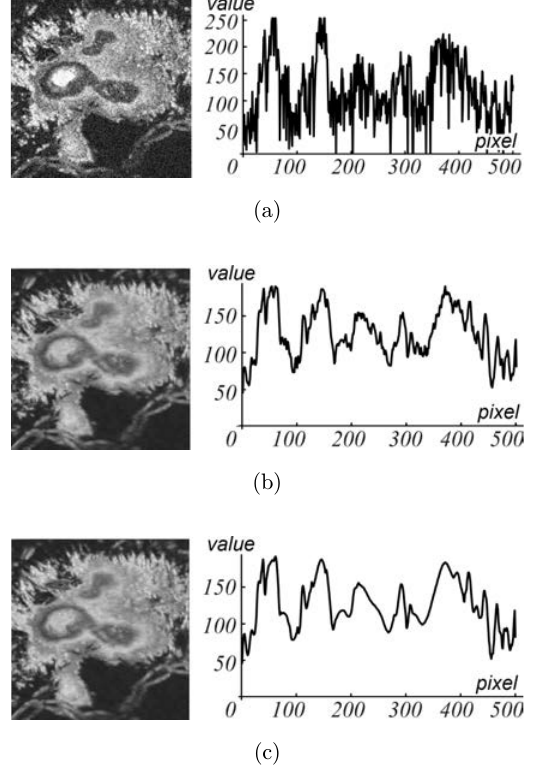
Fig. 2. C-scans (500 (cid:2) 500 px) of SD OCT and its middle y -line of (a) raw (b) pre-¯ltered ( K ¼ 9); (c) EMD-¯ltered ( T ¼ 10) image of implant under the layer of mouse skin.